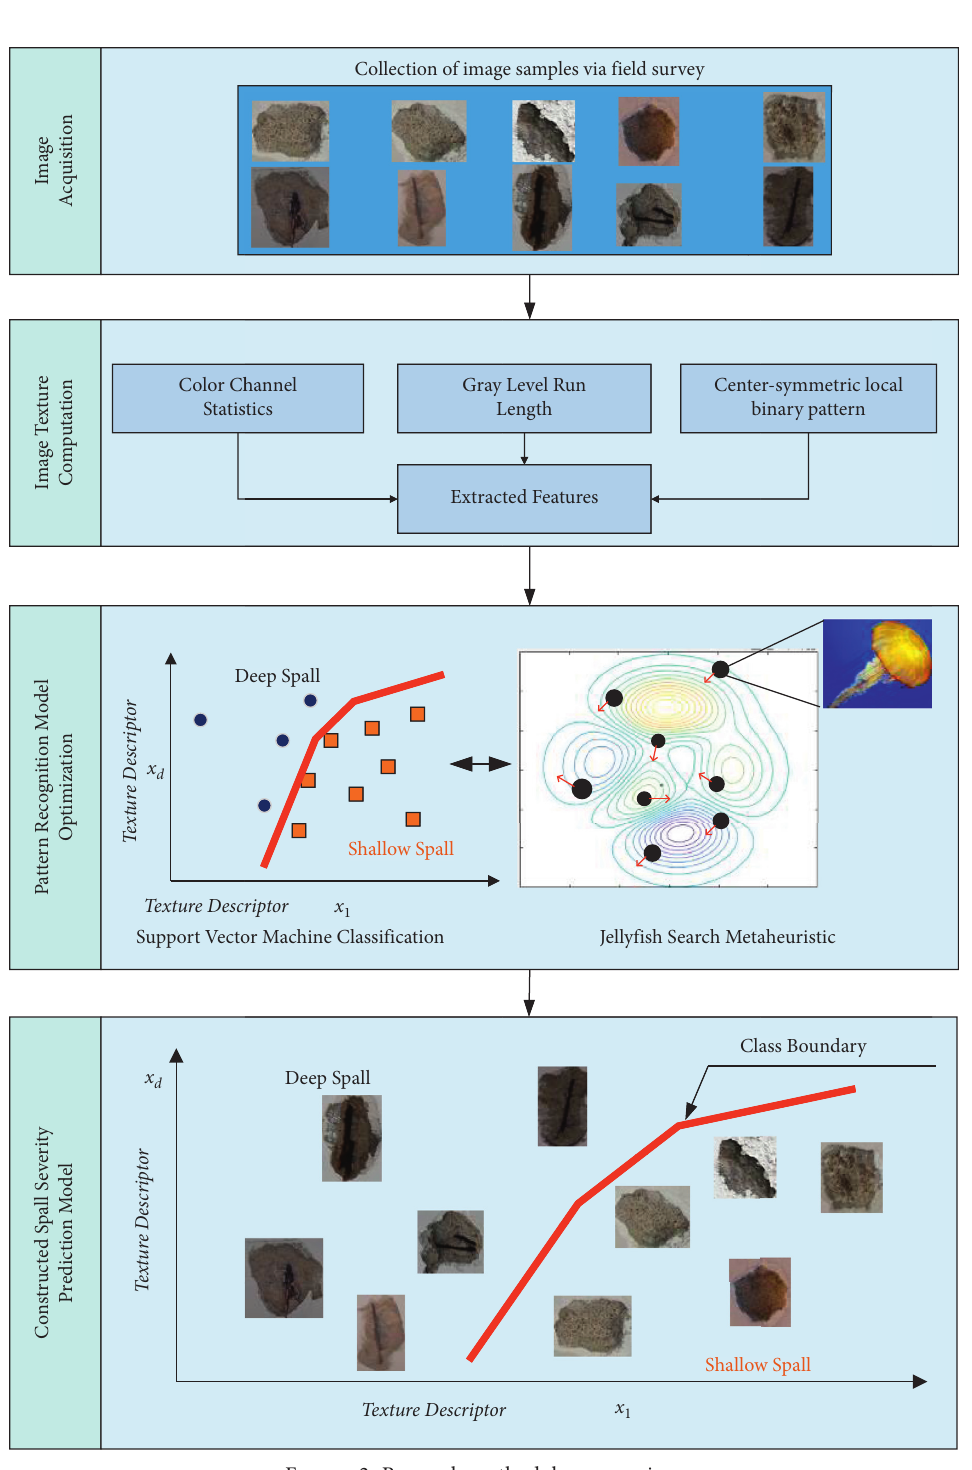
Figure 2: Research methodology